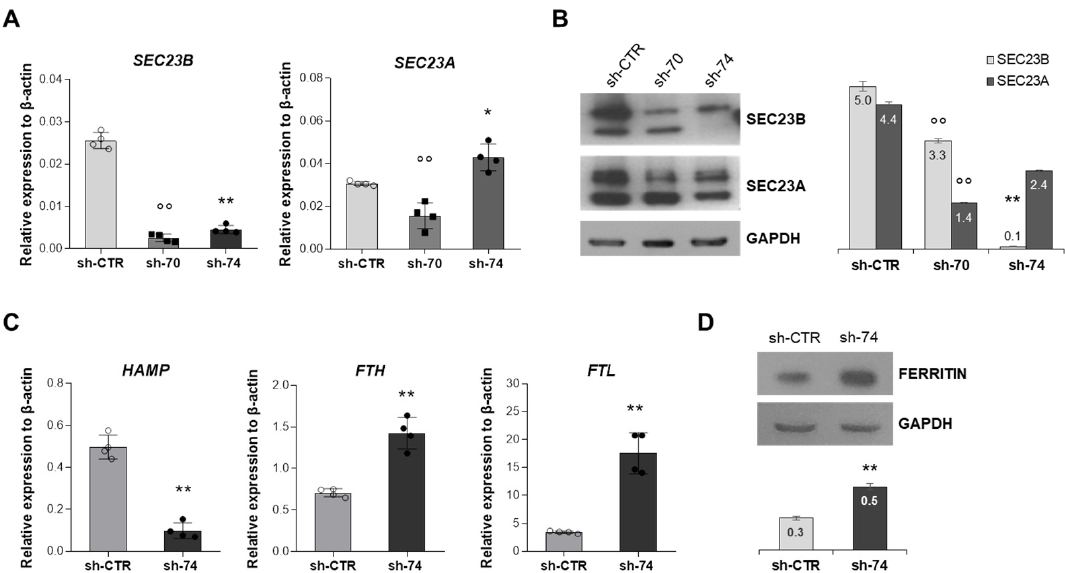
Figure 2. Characterization of HuH7 silenced for SEC23B . ( A ) SEC23B and SEC23A gene expression in HuH7 clones silenced for SEC23B , sh- SEC23B -70 (sh-70), and sh- SEC23B -74 (sh-74) compared to control cells (sh-CTR). Data are means ± standard deviation of three independent experiments (* p < 0.05, sh-CTR vs. sh-74; ** p < 0.01, sh-CTR vs. sh-74; ◦◦ p < 0.01, sh-CTR vs. sh-70; Student’s t -test). ( B ) Representatives immunoblot of SEC23B and SEC23A in HuH7 sh-70, sh-74, and sh-CTR cells (left panel) and densitometry quantification (right panel). Data are means ± standard deviation of three independent experiments (** p < 0.01, sh-CTR vs. sh-74; ◦◦ p < 0.01, sh-CTR vs. sh-70; Student’s t -test). ( C ) HAMP , FTL , and FTH gene expression in HuH7 sh-74 compared to HuH7 sh-CTR cells. Data are means ± standard deviation of three independent experiments (** p < 0.01; Student’s t -test). ( D ) Representatives immunoblot of ferritin in HuH7 sh-74 compared to HuH7 sh-CTR cells and densitometry quantification. Data are means ± standard deviation of three independent experiments (** p < 0.01; Student’s t -test).